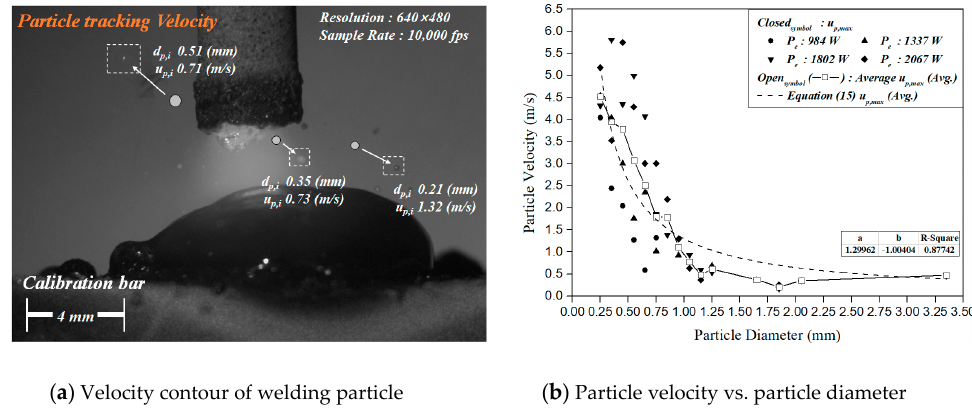
Figure 9. Results of the particle velocity according to the particle diameter.